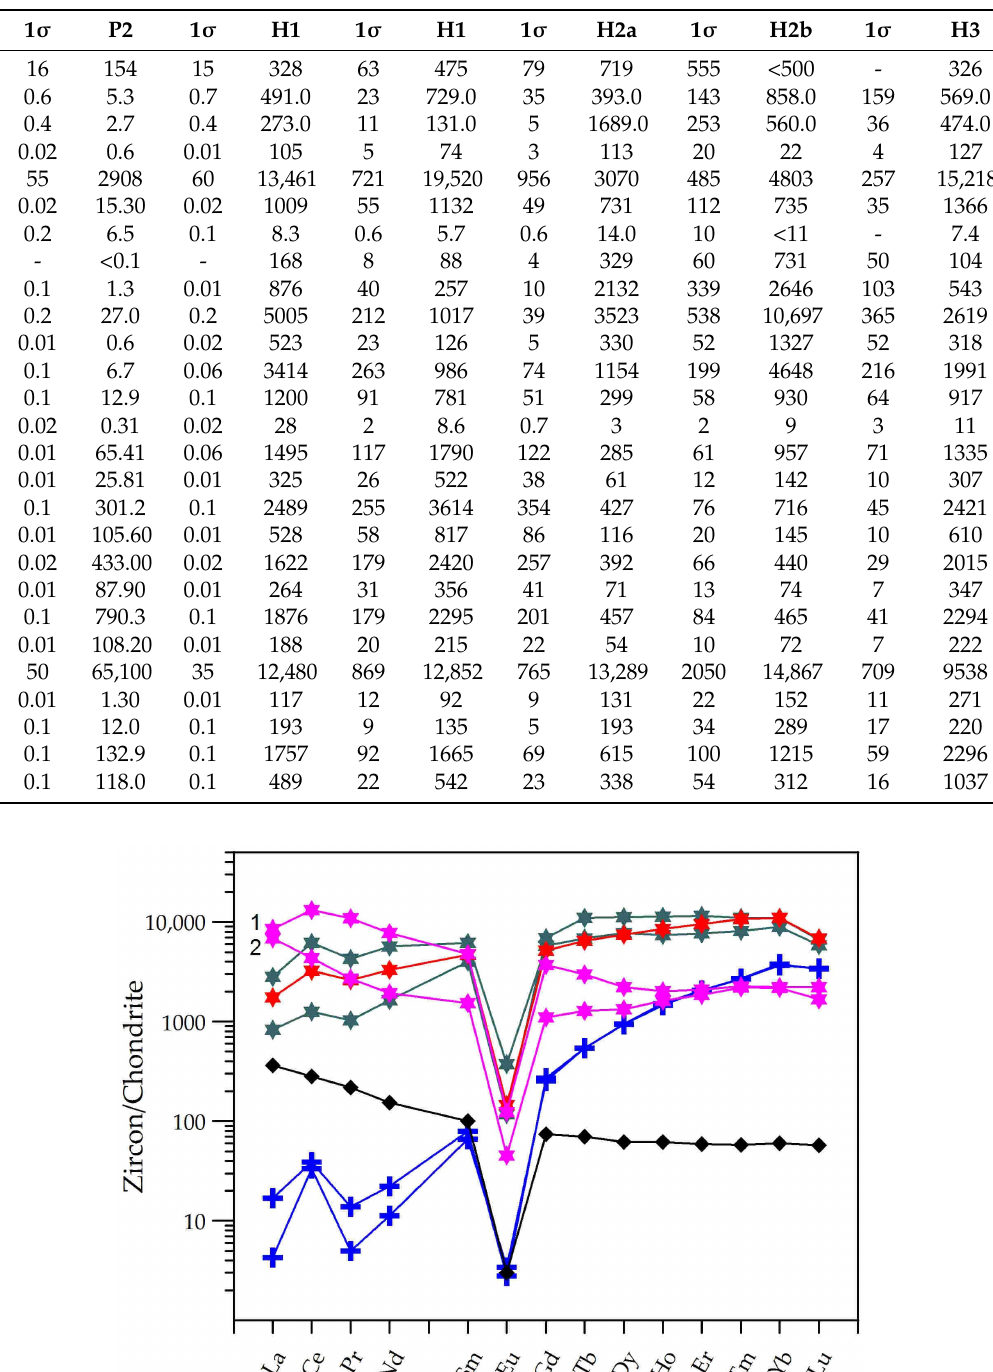
Table 2. Trace-element compositions (ppm, LA-ICPMS) of primary (P) and hydrothermal (H) zir- con crystals and aggregates, respectively, as well as the associated analytical errors (1 σ ). P1 and P2 spot locations as provided in Figure 4a,c, respectively. H1 = botryoidal globules; H2a = fibro- radiated crypto-crystalline, brown core; H2b = fibro-radiated crypto-crystalline, colorless over- growth; H3 = spherulitic, colorless, fibro-radiated aggregate associated with allanite-(Ce), as shown in Figure 2f.